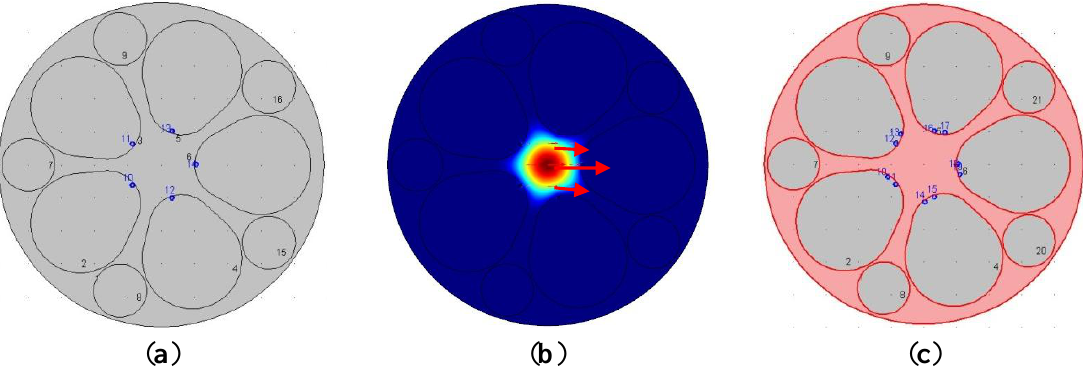
Figure 1. ( a ) Structure diagram of the grapefruit PCF occupied by silver nanowires (indicated by blue dots) of 300 nm; ( b ) Optical field distribution of the fundamental mode (the wavelength of the incident light is 600 nm); ( c ) Structure diagram of the grapefruit PCF occupied by two silver nanowires (è ≈